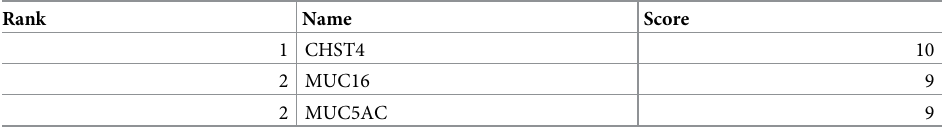
Table 3. Top 3 genes in network ranked by degree method.